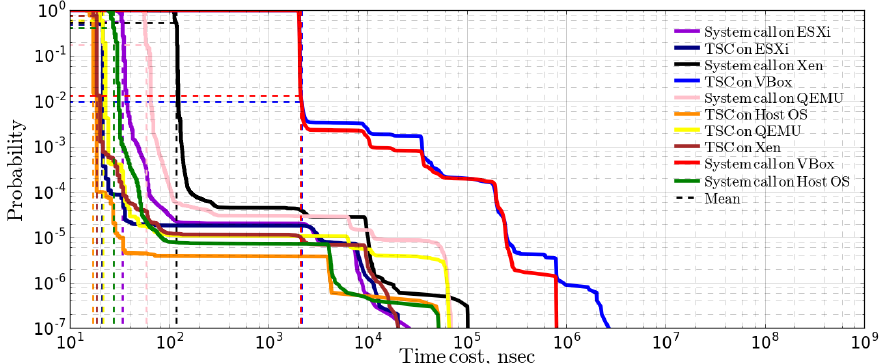
Figure 5. CCDF representation of measurements of time cost for the idle testbed.